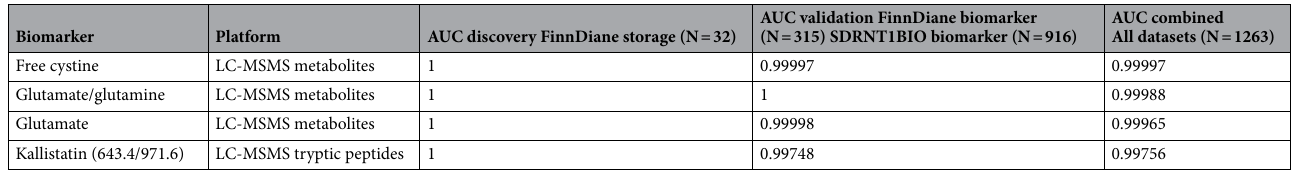
Table 3. Performance of the candidate biomarkers classifying the samples based on the storage temperature measured by area under the receiver operating characteristics curve (AUC) in the discovery (16